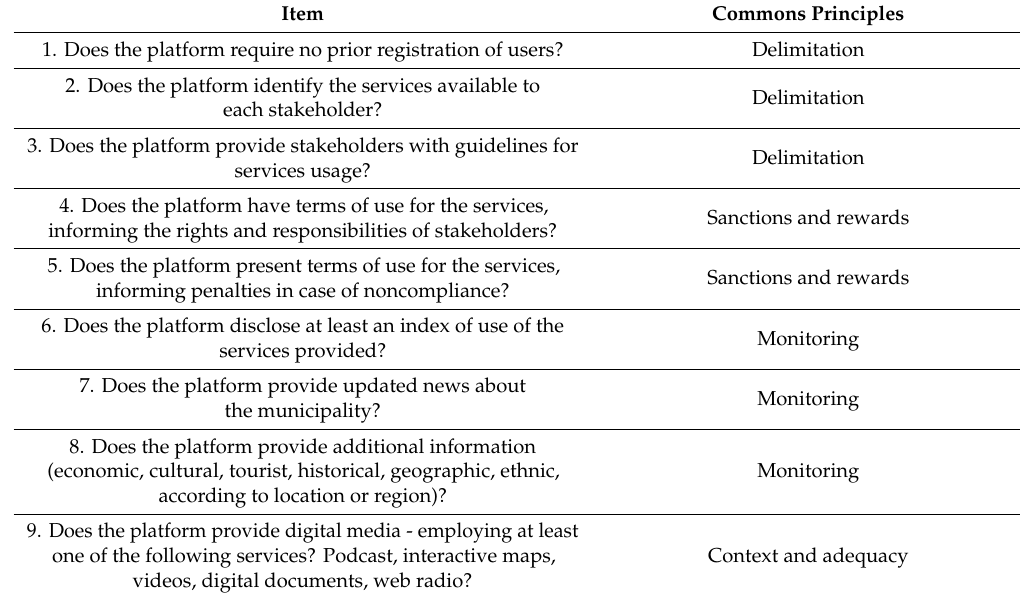
Table 5. Evaluation instrument